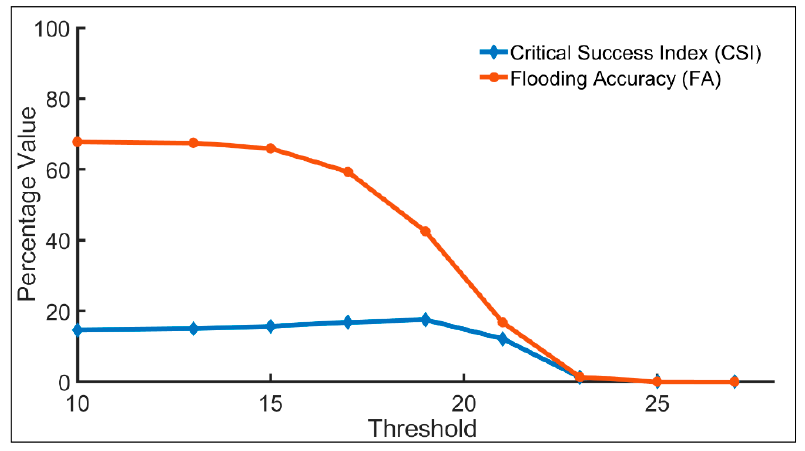
Figure 8. Mapping CSI and FA of proposed model output compared with Sentinel-derived flood inundation map for Kerala flood event of August 2018.